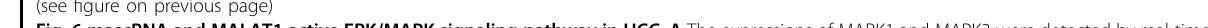
(Fig. 6J, K). The increased activity of ERK signaling was also con fi rmed by dual-luciferase reporter assays (Fig. 6L, M). Since mascRNA activated ERK signaling without affecting the mRNA expressions of MAPK1 and MAPK3, it might affect p-ERK at post-transcription level.